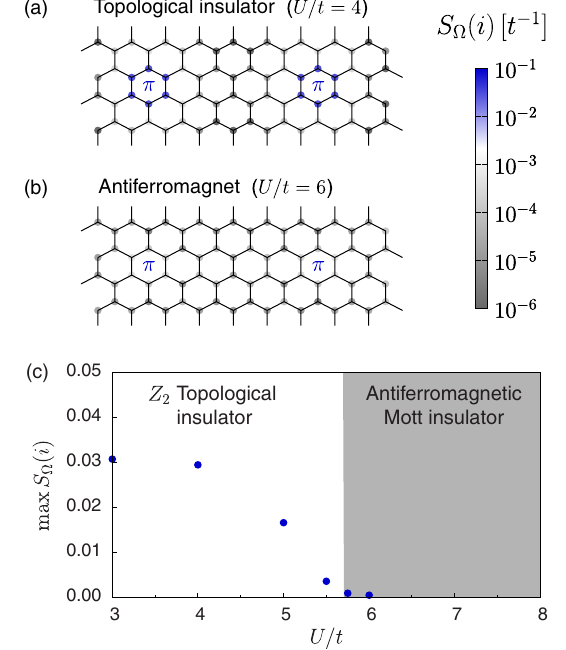
FIG. 5. Integrated dynamical spin-structure factor S (cid:2) ð i Þ at T ¼ 0 on a 9 (cid:4) 9 lattice. (a) Localized spin fluxons created in the topological-insulator phase at U=t ¼ 4 . (b) Absence of spin fluxons in the magnetic phase at U=t ¼ 6 . (c) Maximum of S (cid:2) ð i Þ , as a function of U=t . Here (cid:4)=t ¼ 0 : 2 , (cid:5) ¼ 0 , and (cid:2) =t ¼ 0 : 2 .